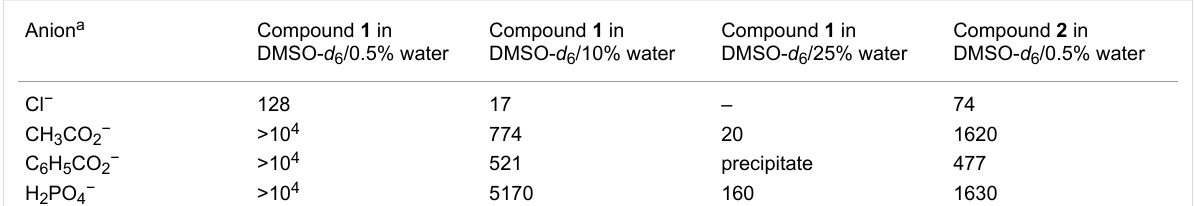
Table 1: Stability constants of compound 1 measured in DMSO- d 6 /0.5% water, DMSO- d 6 /10% water and DMSO- d 6 /25% water and compound 2 in DMSO- d